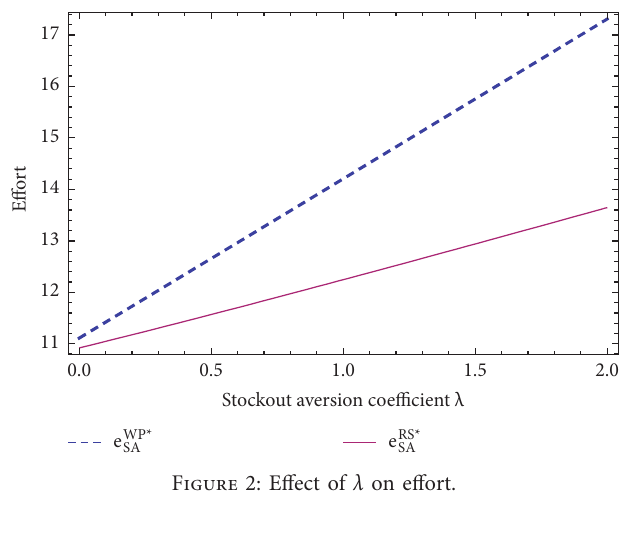
Figure 2: Effect of λ on effort.